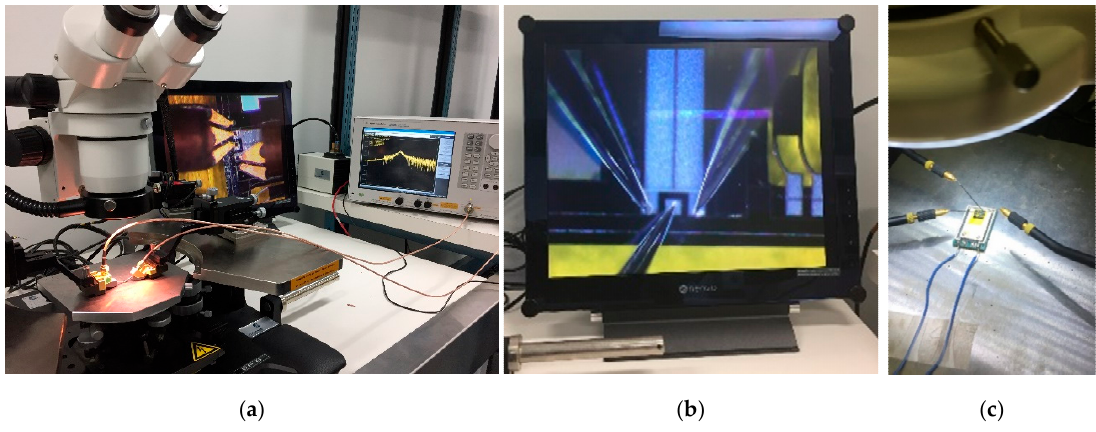
Figure 13. Photos of ( a ) the experimental test setup; ( b ) the device with the electrical probe tips; and ( c ) the piezospeaker setup with the device under test attached to it.